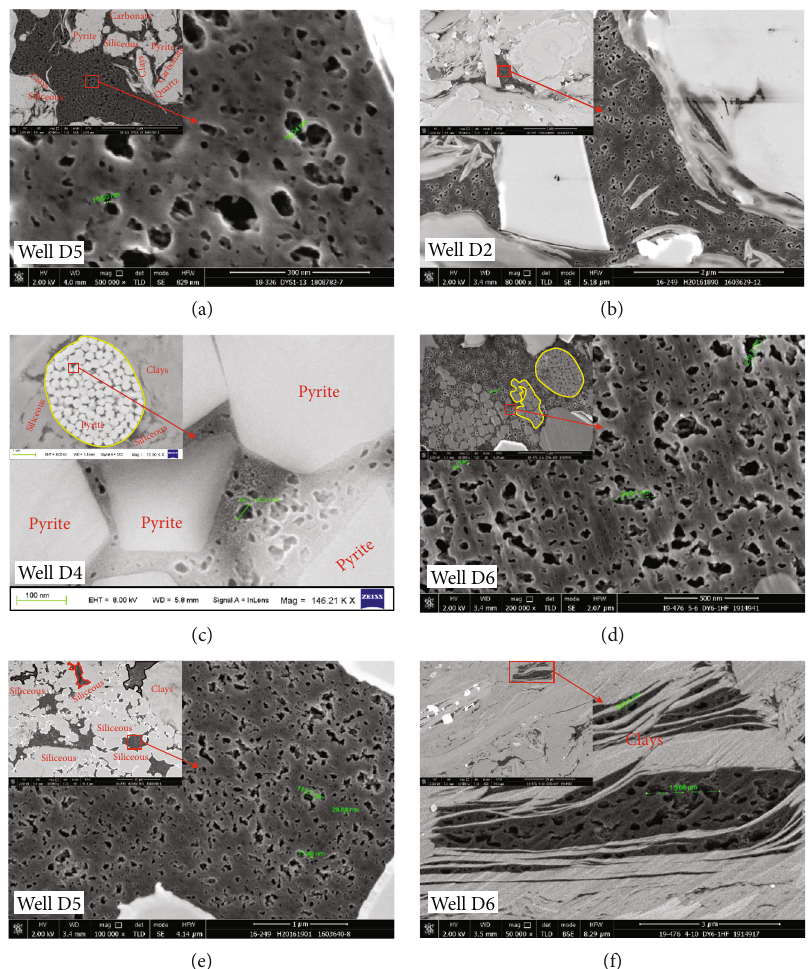
Figure 5: Characteristic of migrated organic matter and their organic matter pores in Longmaxi formation shale in Dingshan fi eld under SEM. (a, b) Migrated organic matter and its organic matter pores between silicate particles. (c) Migrated organic matter and its organic matter pores in the intercrystalline pores between pyrite monocrystals. (d) Migrated organic matter and its organic matter pores in the interparticle pores between framboidal pyrite and surrounding minerals. (e) Migrated organic matter and its organic matter pores between particles. (f) Migrated organic matter and its organic matter pores in the interparticle pores between clay minerals. Table 3: The results of pore development density, shape coe ffi cient, and fractal dimension in di ff erent wells. Parameters